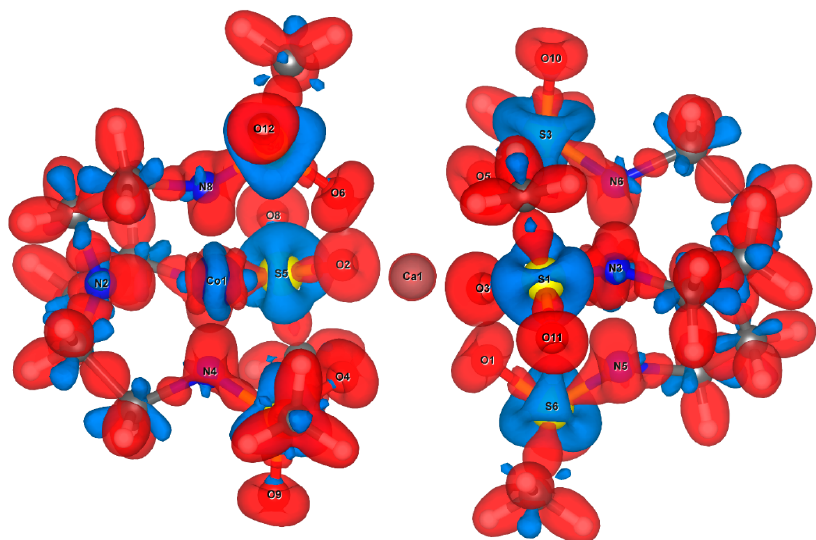
Figure 4. Positive and negative deformation-density isosurfaces (0.02 eÅ − 3 ) of the dimeric Co 2+ complex, [C 36 H 78 CaCo 2 N 8 O 12 S 6 ], from refinements with the predicted multipolar parameters. Charge concentrations are shown in red, and charge depletions are shown in blue.